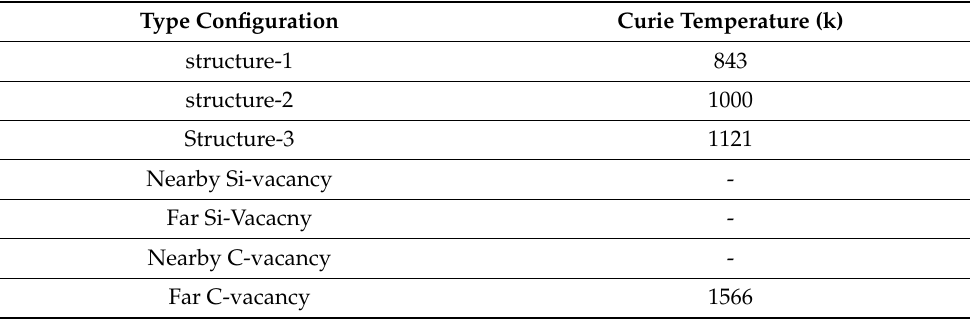
Table 4. The predicated Curie temperature of (Mn +2 )-doped